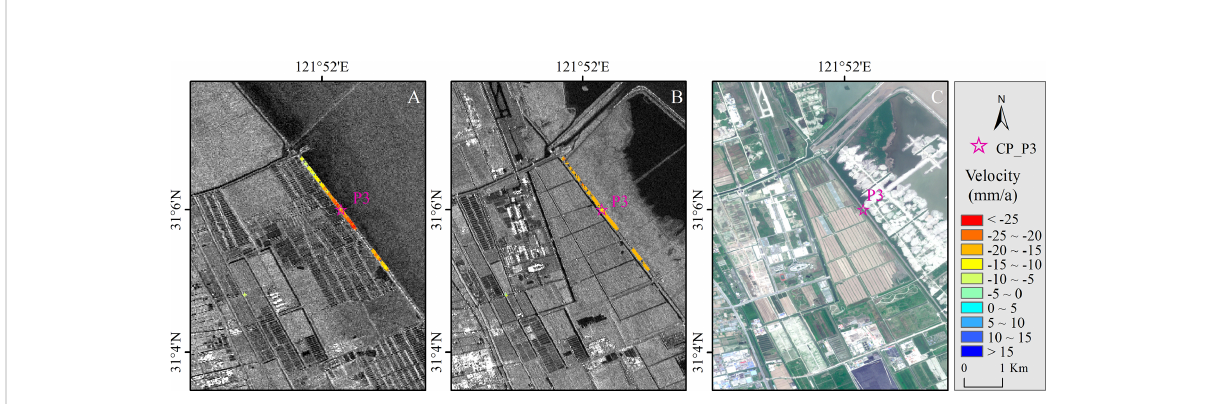
FIGURE 10 Subsidence comparison of typical site (CP_P3) in Nanhui Dongtan Reclamation Project during the two periods of 2007-2010 (A) and 2017-2020 (B) . The background of this fi gure (A – C) is the same as that of Figure